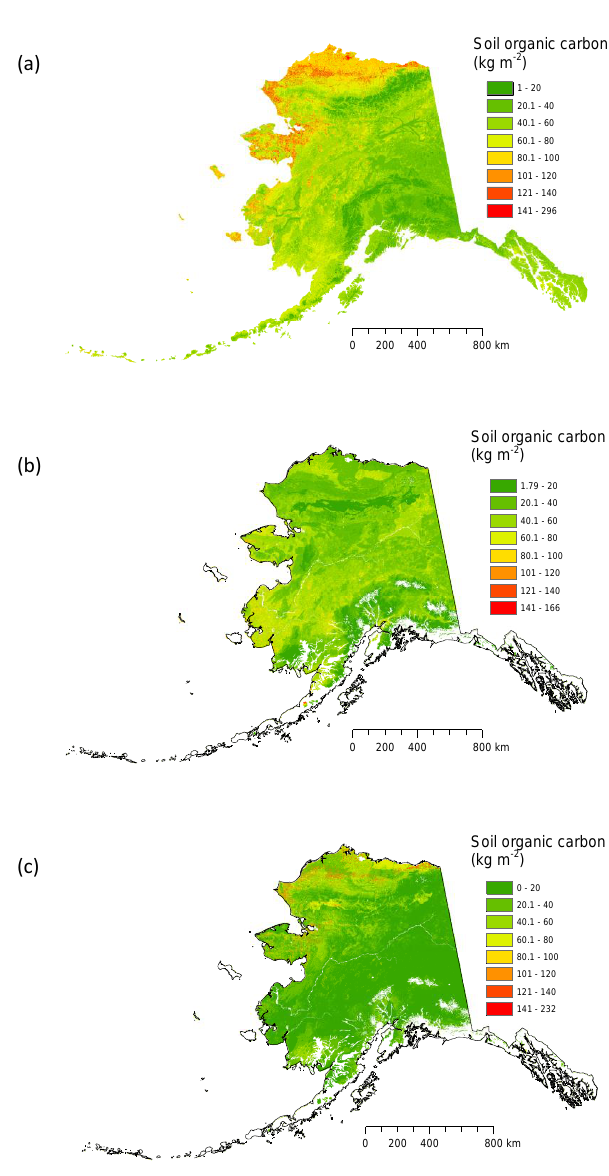
Fig. 1. Predicted soil organic carbon stocks in (a) whole-profile, (b) Figure 1. active-layer, and (c) permafrost layers in